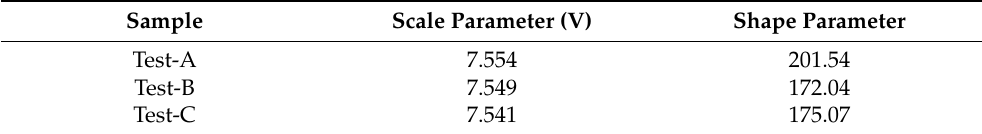
Figure 4. ( a ) XPS spectra of carbon and ( b ) Weibull distribution curves for breakdown voltage. Table 1. Weibull parameters for breakdown voltage in Figure